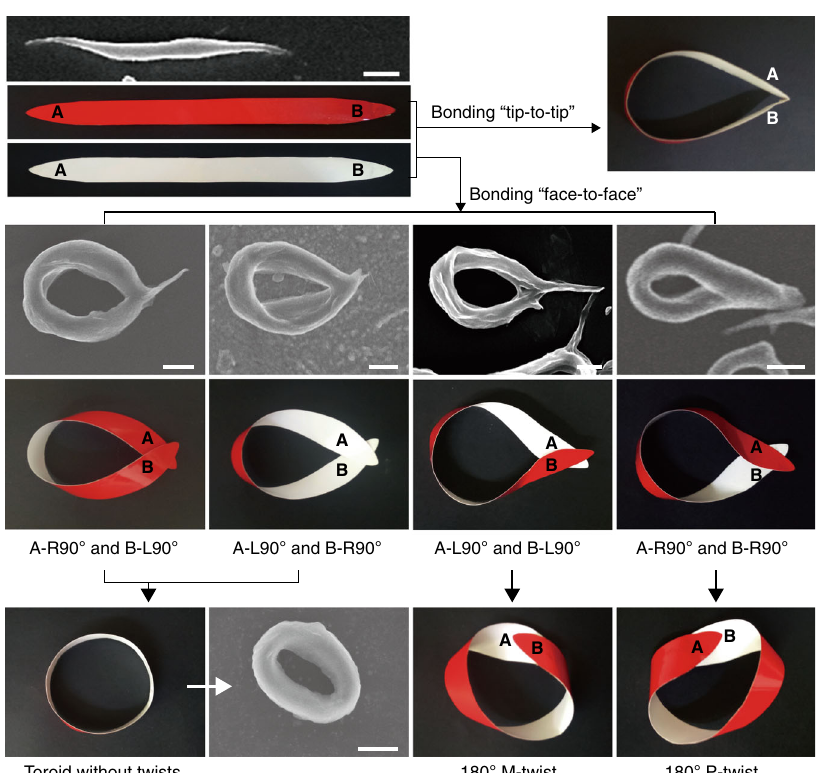
Fig. 5 Mechanism insights in the formation of BCPs Moebius strips. Schematic representation of the probable modes for the closing of SLMs into toroidal micelles: the two ends (A and B) of SLMs could bond to each other tip-to-tip or more ef fi ciently through four types of face-to-face way (A-R90°&B-L90°, A-R90°&B-R90°, A-L90°&B-L90°, and A-L90°&B-R90°). Three kinds of toroids (toroid without twists, 180° M-twisted toroid, and 180° P-twisted toroid) could form after closing of SLMs into toroids. Scale bars: 500 nm